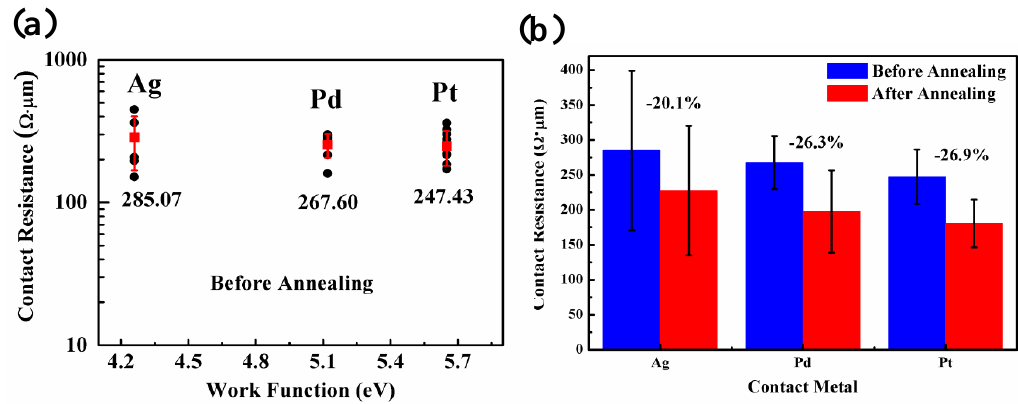
Figure 5. ( a ) Specific contact resistance as a function of metal work functions (Ag, Pd, and Pt). Filled black circles (●) represent extracted R c values for different metals (Ag, Pd, and Pt). Filled red squares ( ■ ) depict the mean R c values with error bar; ( b ) Extracted average R c values with error bar for all G-M contacts (Ag, Pd and Pt/graphene) before and after annealing.